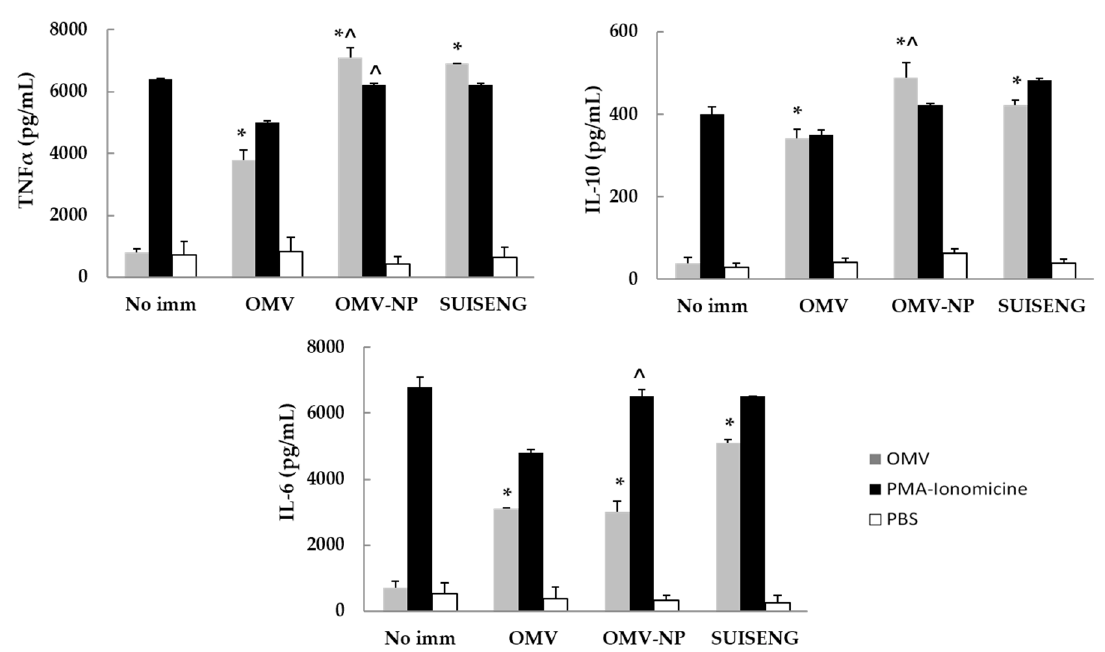
Figure 6. Splenic cytokine profile after immunization of pregnant BALB/c mice. Production of IL-6, IL-10 and TNF α by splenocytes restimulated with OMV in vitro was determined at day 28 post-immunization. The results are shown as the mean levels for triplicate determination ± SD (* p < 0.05 for immunized mice vs. control; ^ p < 0.05 OMV-NP vs. free OMV).